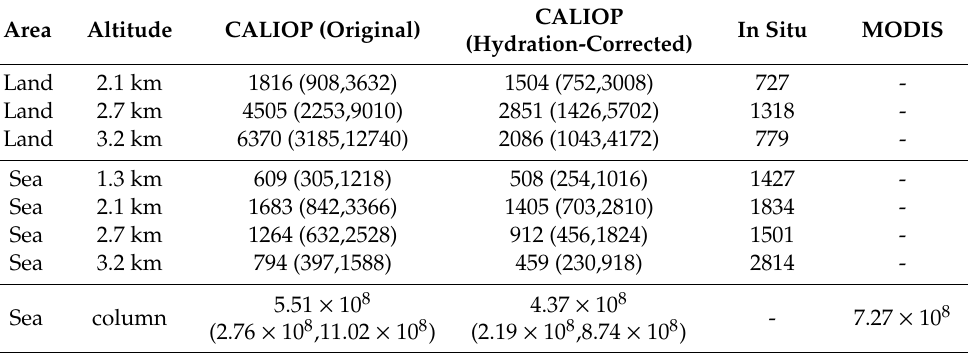
Table 1. Original and hydration-corrected CALIPSO-derived CCN concentrations (in cm − 3 ) and dry particle number concentrations (in cm − 3 ), retrieved with the IRRA algorithm using ACEMED flight measurements at di ff erent height levels over Thessaloniki, Greece. The factor of two uncertainty range is given in parentheses. Columnar CCN concentrations (including particles with radius larger than 30 nm) based on the original and the corrected CALIPSO data and collocated MODIS PSML003_Ocean data (in cm − 2 ) are also